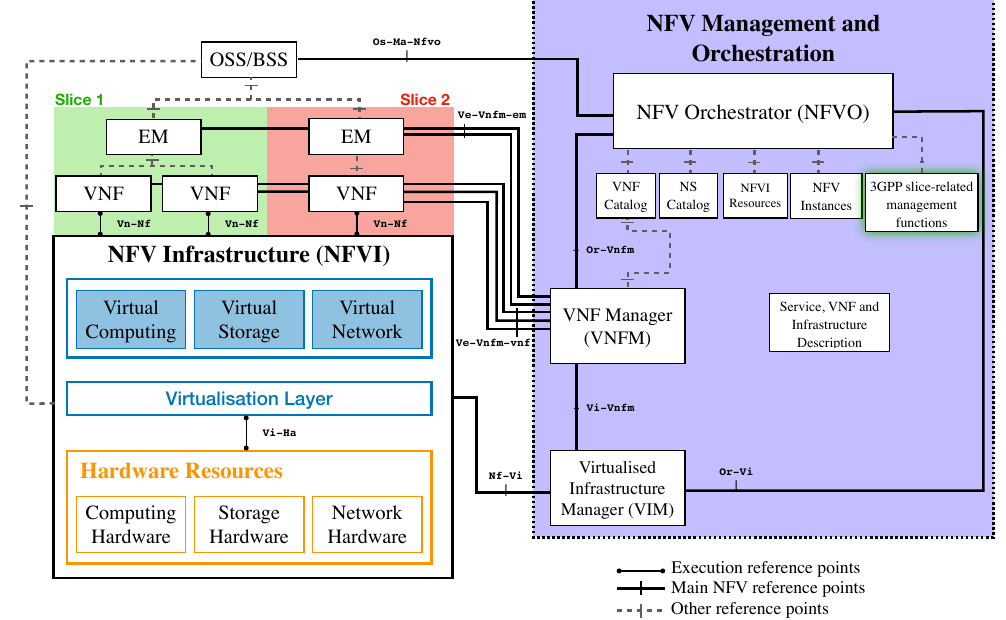
Figure 10. ETSI NFV MANO Architecture: highlighting slices’ reference points and manager in an integrated NFV MANO model